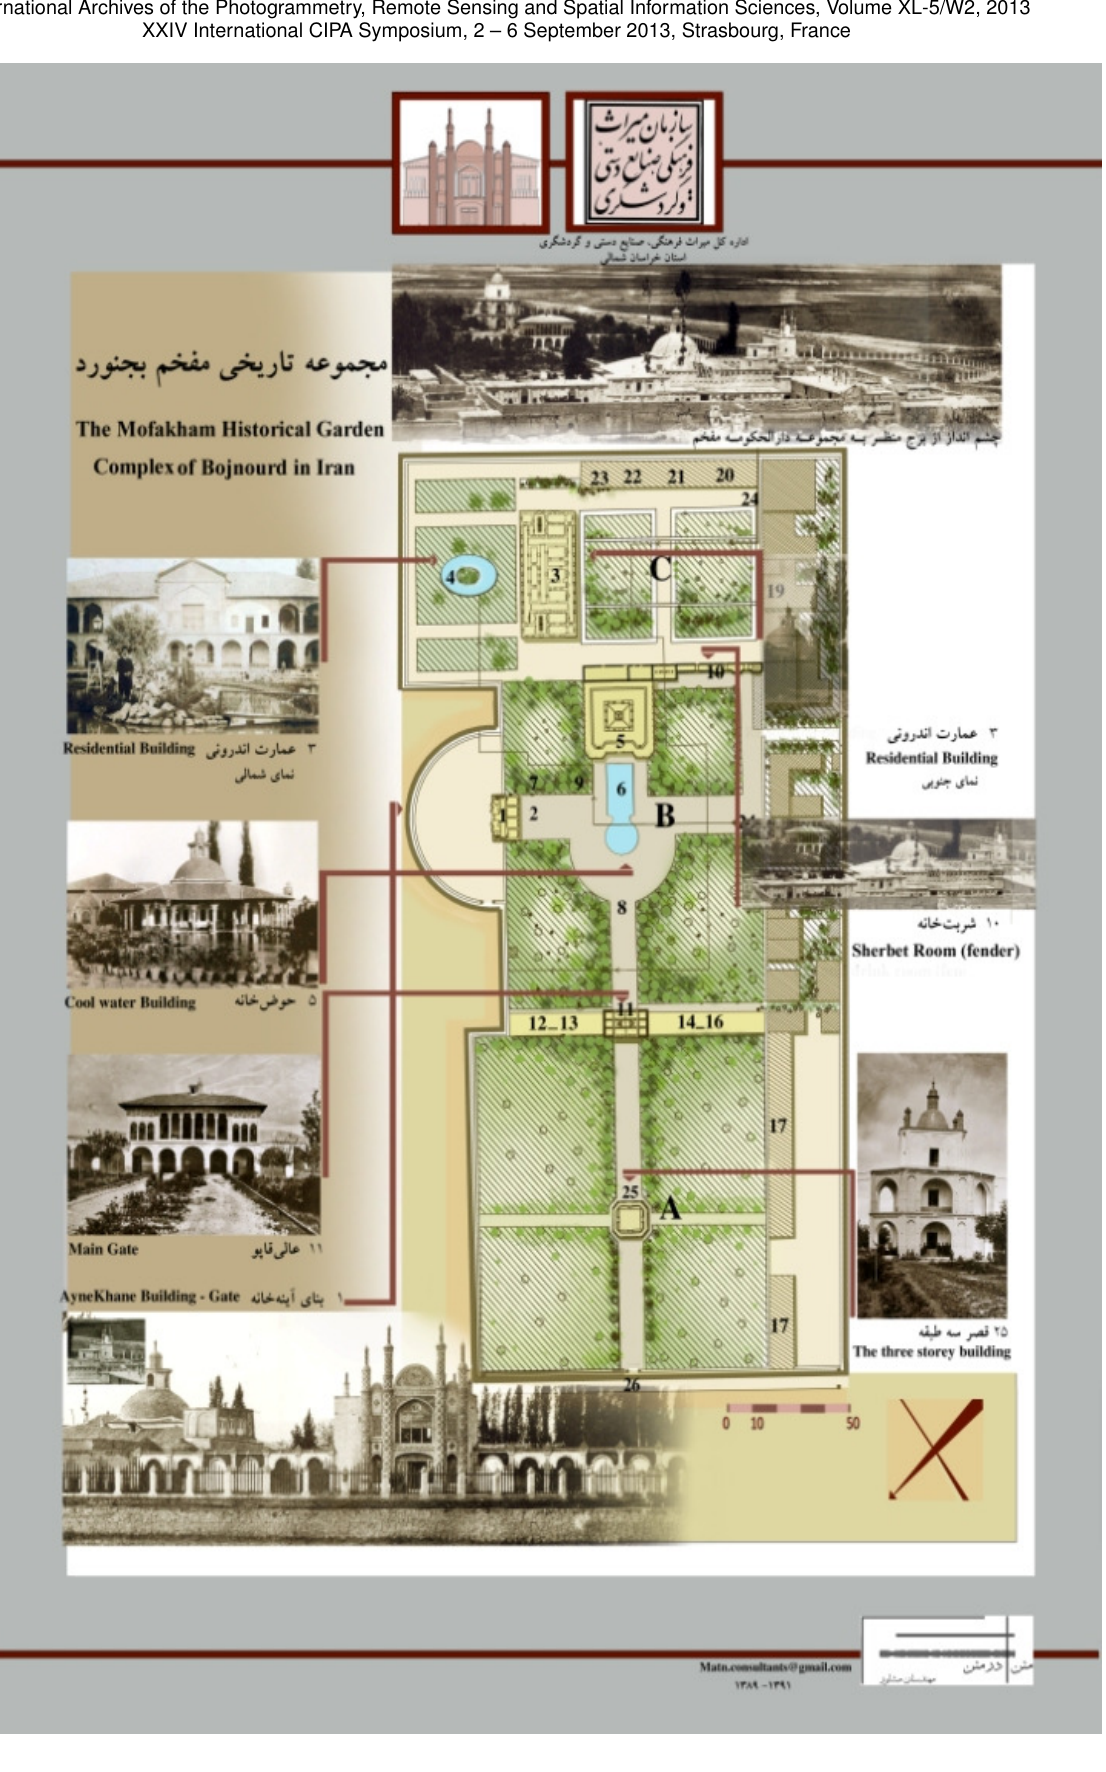
Figure 3: Images of Mofakham complex in